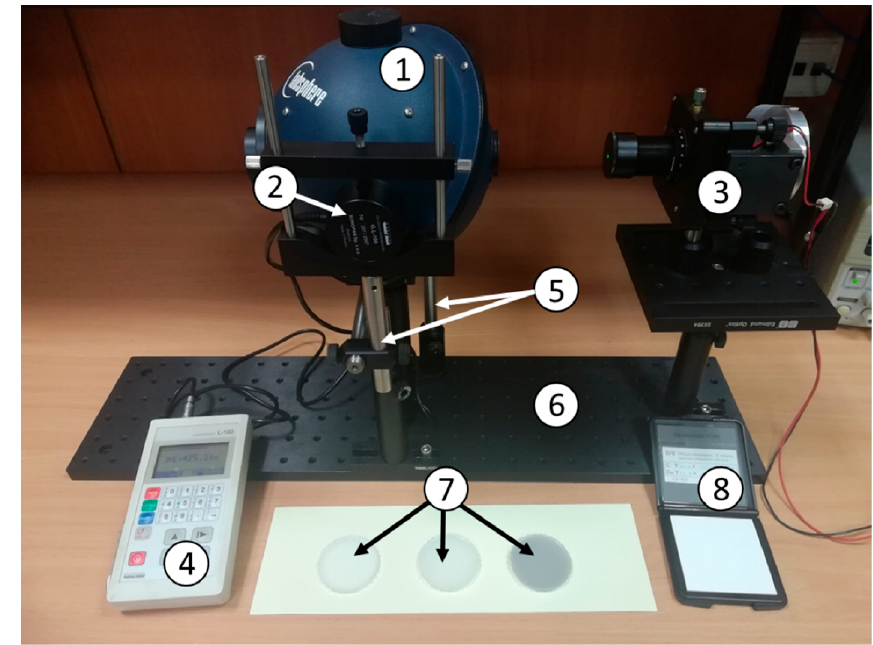
Figure 2. Setup for the measurement of diffuse reflectance R d . 1—integrating sphere Labsphere, 2—luxmeter measuring head, 3—light source, 4—luxmeter, 5—rotation stoppers, 6—optical breadboard, 7—prepared phantoms, 8—white calibration plate CS-A21 by Konica Minolta.